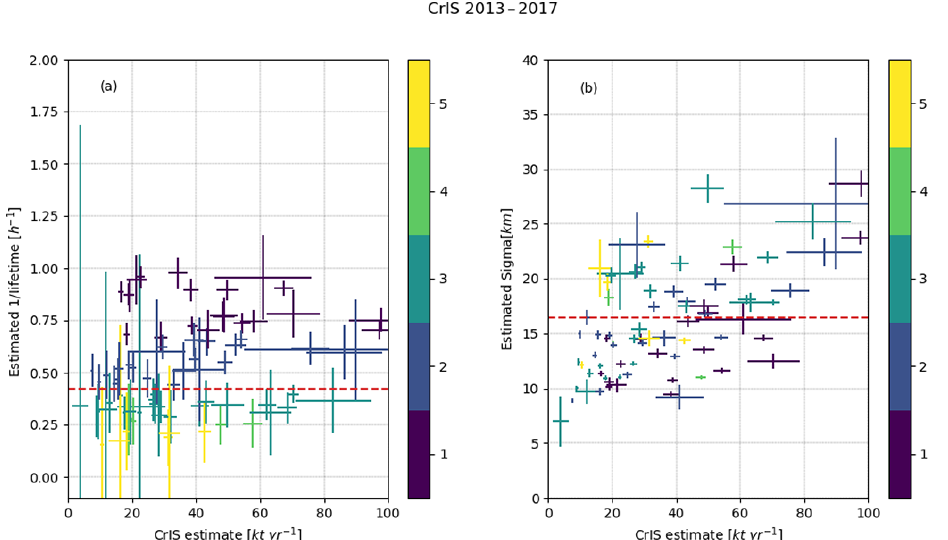
Figure 5. All successful fits for the 5-year (2013–2017) CrIS dataset with a correlation > 0.5 and a SNR > 2. The left plot (a) shows the fitted emissions vs. the λ parameter and the right plot (b) the fitted emissions vs. the fitted σ with the horizontal and vertical error bars showing the uncertainties of the fit. The color of the bars indicates the fitted lifetime (in hours) rounded to the nearest integer. The horizontal striped red lines show the average of the 1 /λ and σ